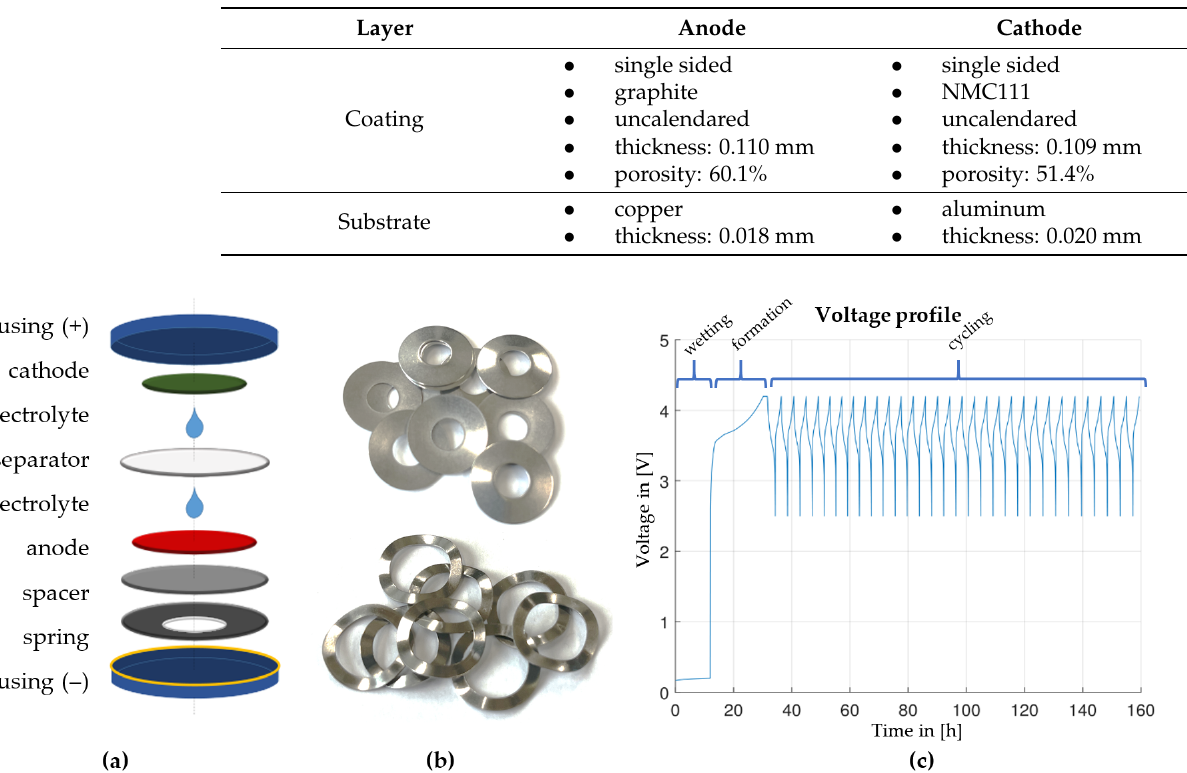
Figure 2. ( a ) Coin cell components; ( b ) spring types: wave springs ( top ) and disk springs ( bottom ); ( c ) voltage profile for wetting, formation and cyclic aging.